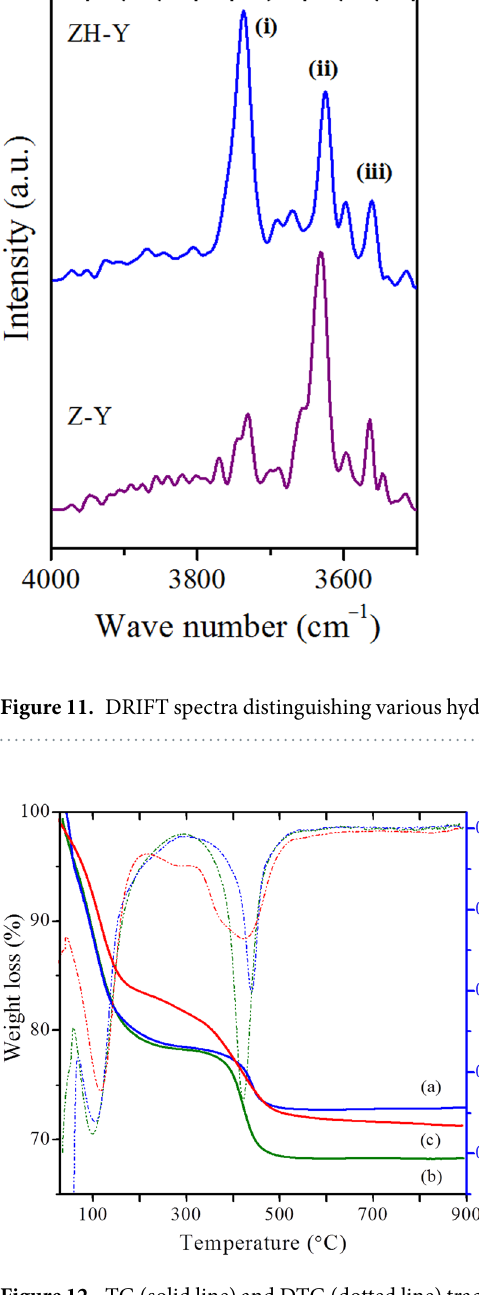
Figure 12. TG (solid line) and DTG (dotted line) traces of: (a) ZH-Y; (b) ZH-X; (c)